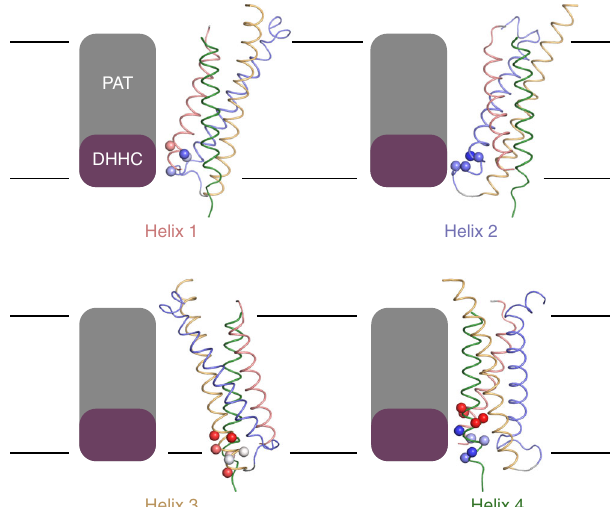
Fig. 4 Cysteine palmitoylation is restricted by palmitoyl-acyl transferases (PAT) accessibility. PATs are restricted to lateral diffusion for its catalytic DHHC domain to interact with substrates. The membrane orientation of Cld3 prevents PATs to access palmitoylation sites located on helix 3, whereas palmitoylation sites on helix 1, 2, and 4 are